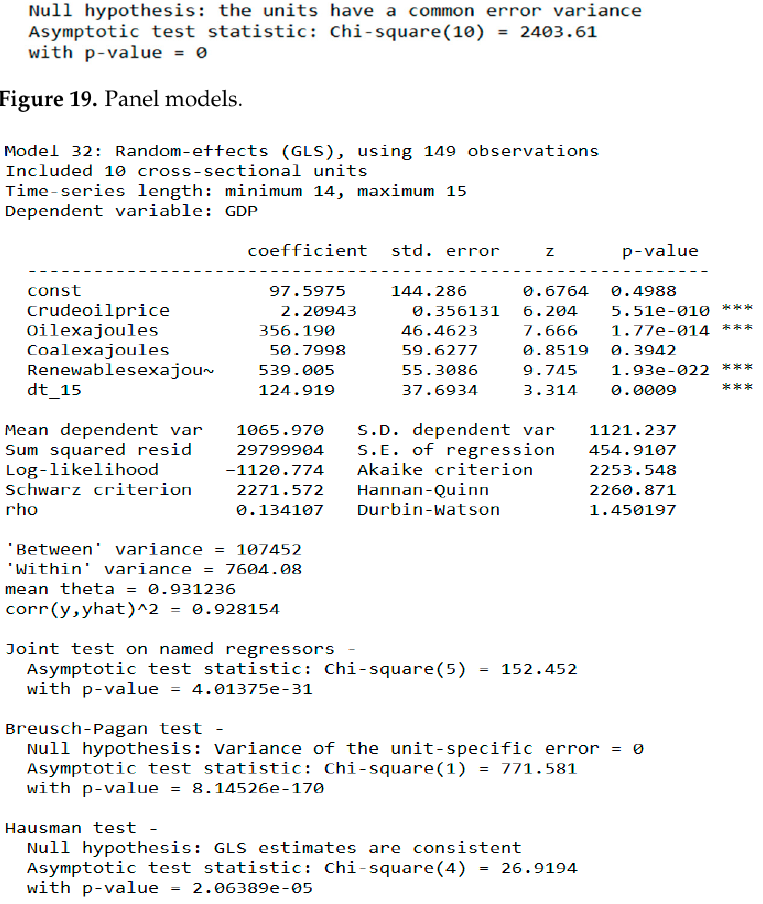
Figure 20. Joint test on named regressors.